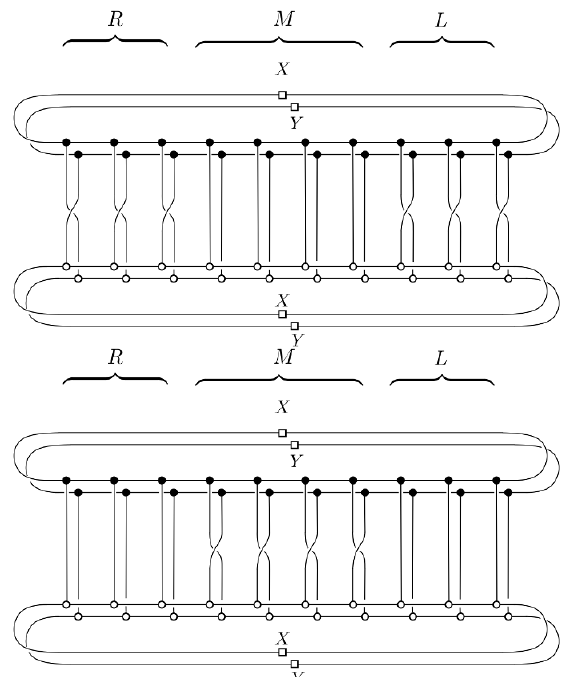
Figure 4 . The two expressions in equation (5.3), where L , M and R are used to denote the sites de(cid:12)ned in